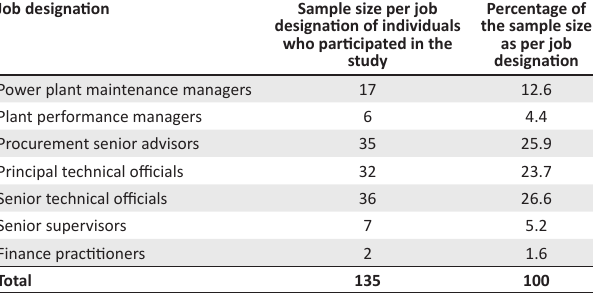
TABLE 2: Sample size by job